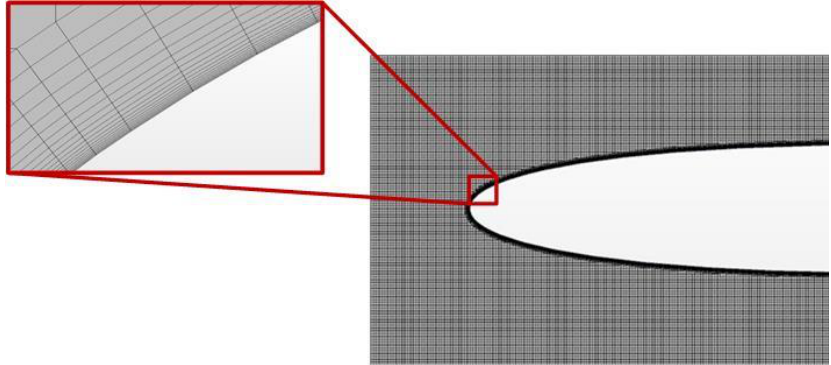
Figure 2. Computational domain.